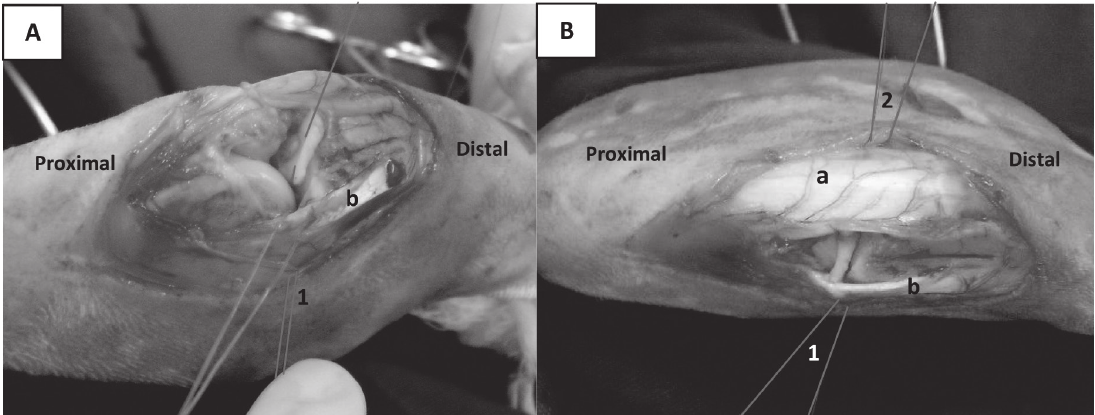
Figure 2 - Meniscal implantation and fixation to the joint. A : meniscus positioned on the tibial plateau. B : Sutures passed through from the inside to the outside of the joint. Patellar tendon (a); medial colateral ligament (b); suture caudal to the medial colateral ligament (1); suture lateral to the patellar tendon (2). (See the colors in the online